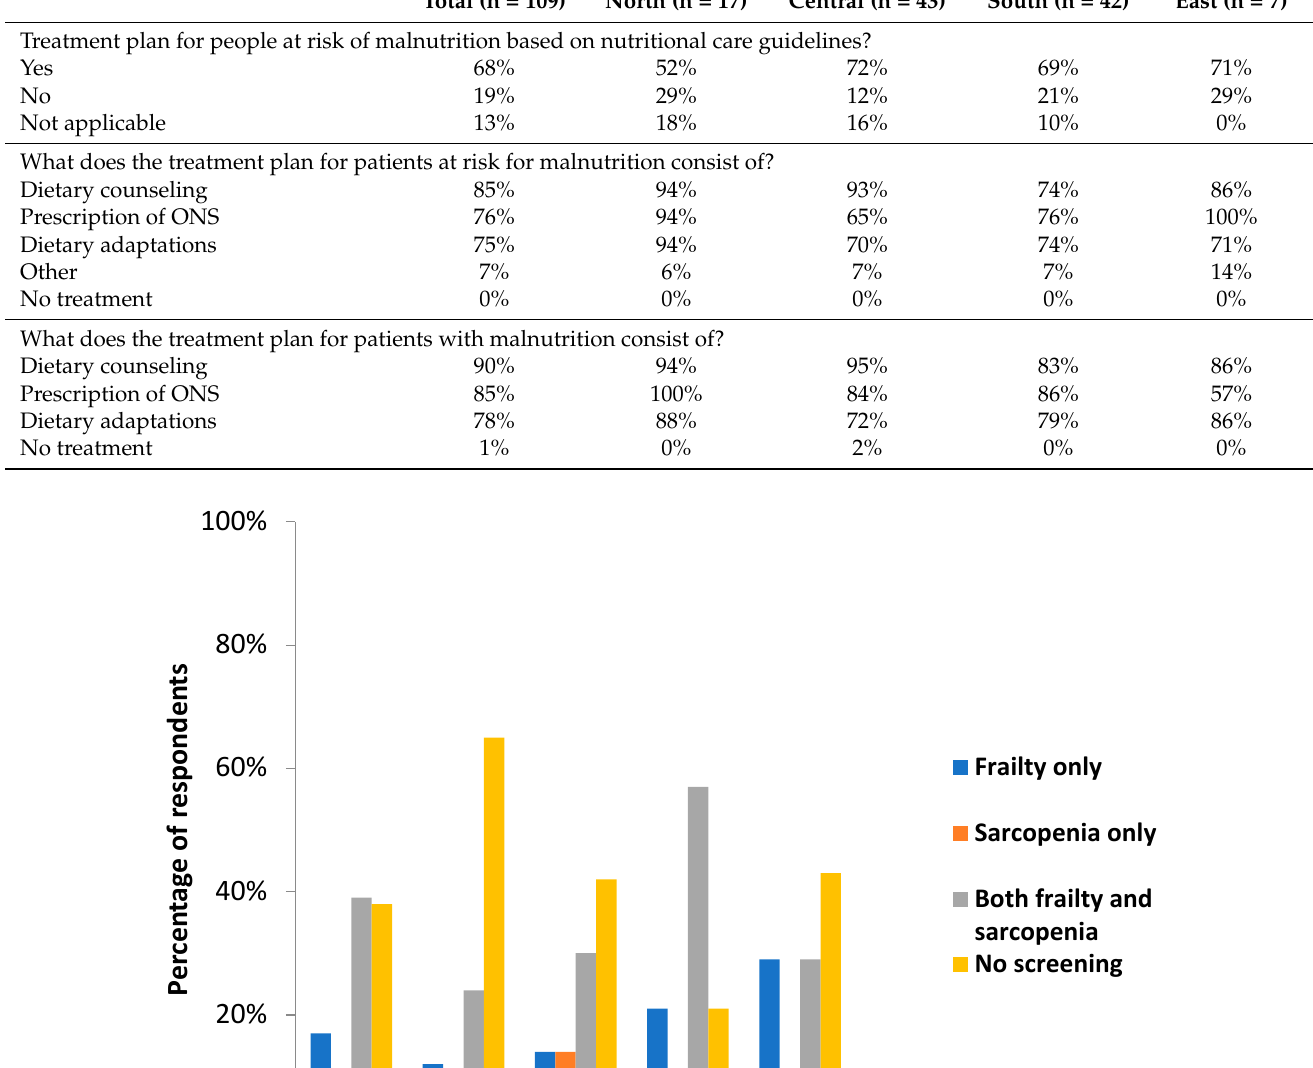
Table 5. Treatment of sarcopenia and frailty.